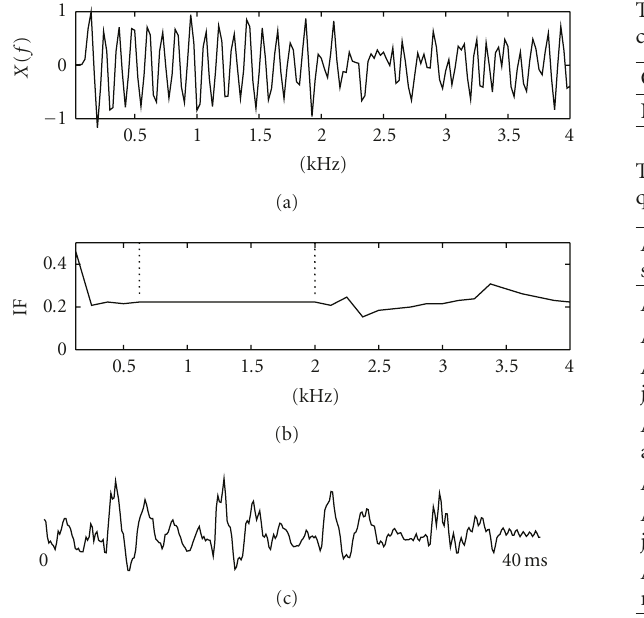
Figure 6: IF based analysis of a mixed-excitation speech signal: (a) absolute value of LPC residual where its mean value is removed, (b) IF contour over frequency domain, and (c) speech signal waveform. The portion of the IF contour between vertical lines is used to compute the fundamental frequency [27].